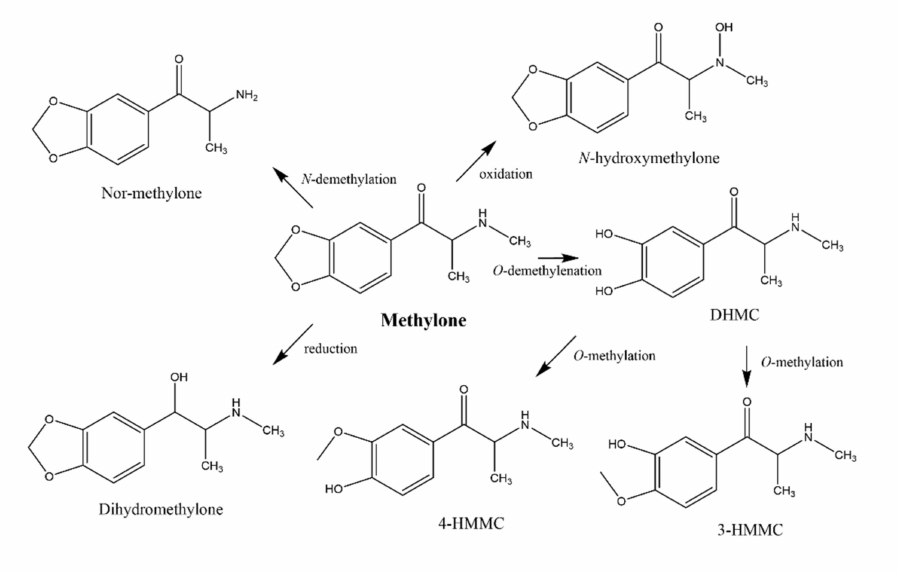
Figure 1. In vitro and in vivo metabolism of methylone. DHMC: dihydroxymethcathinone; 4-HMMC: 4-hydroxy-3-methoxy- N -methylcathinone; 3-HMMC: 3-hydroxy-4-methoxy- N -methylcathinone (adapted from